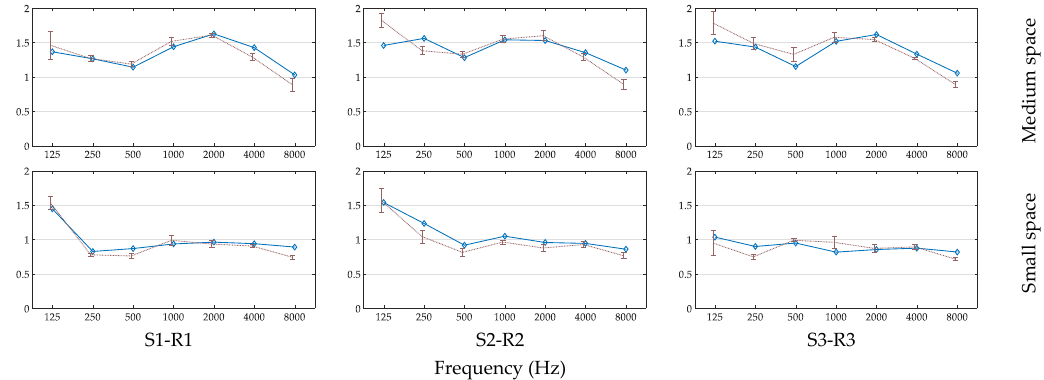
Figure 10. EDT measurements at three positions for three different spaces (i.e., large, medium, small). Error bars represent measured standard deviation.